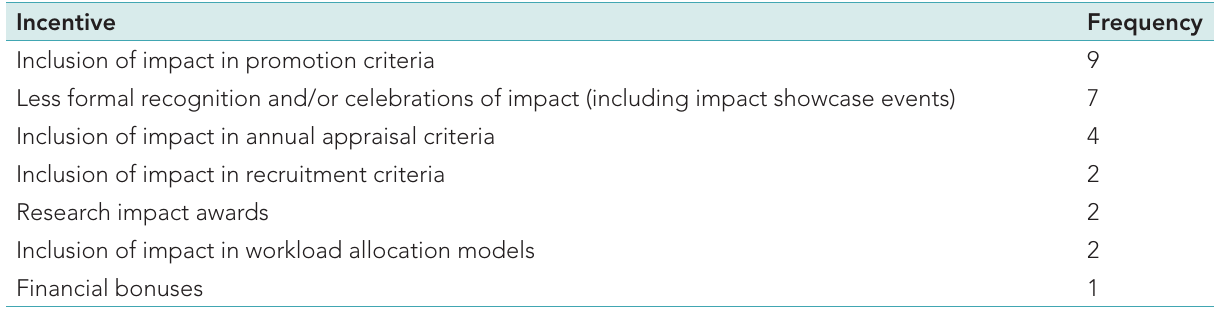
Table 3. Extrinsic incentives designed to increase researcher engagement with impact, ranked by the frequency with which they appeared in strategies (Source: Authors,